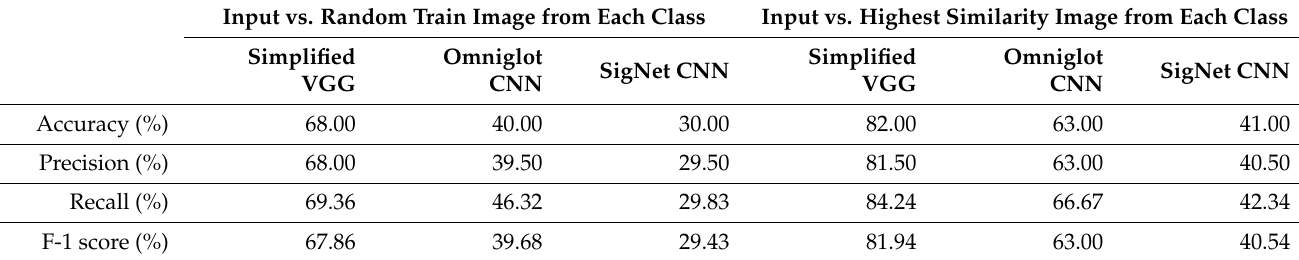
Table 4. Ten-type average classification accuracy. The testing of each architecture is conducted on the same validation set from Table 2. In terms of average accuracy and F-1 score, the Simplified VGG outperforms other networks. Input vs. Random Train Image from Each Class